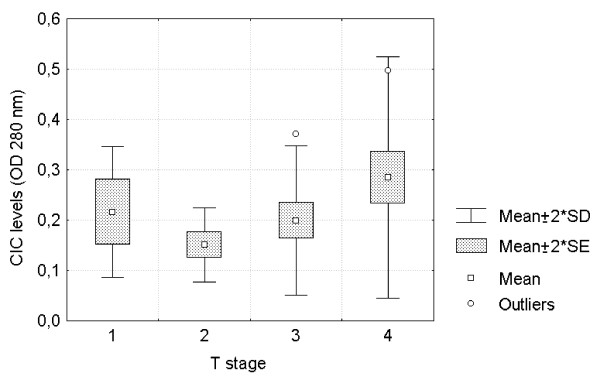
Comparative analysis of circulating immune complexes' levels (OD 280 nm) among different primary tumor T stages. Circulating immune complexes' levels in HNSCC increased with tumor T stage (F = 5.375; p < 0.05).